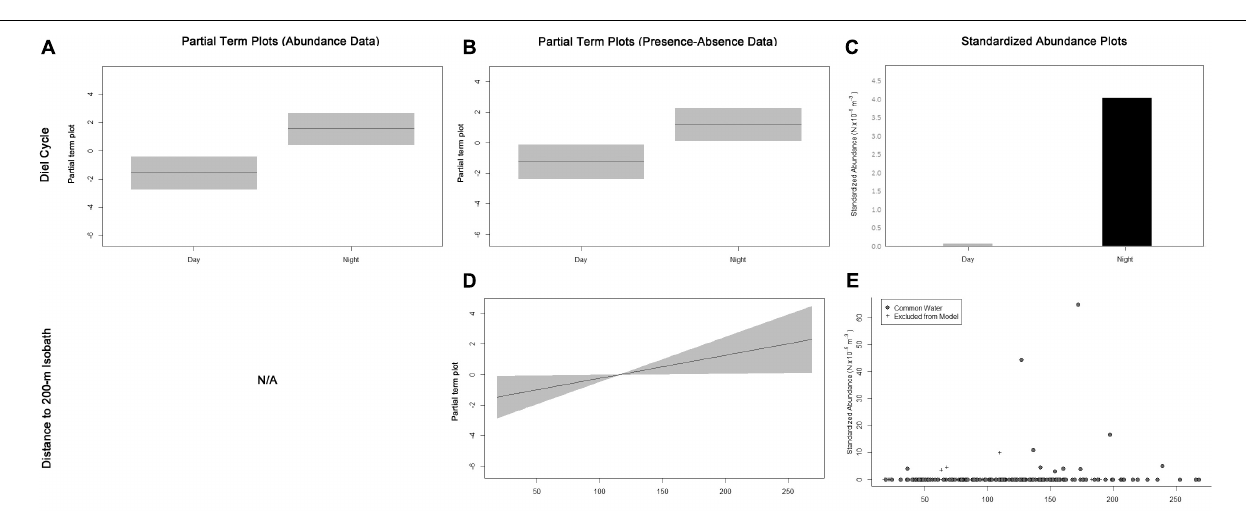
FIGURE 5 | Term plots for the best-fitting models for Auxis thazard data fitted to the abundance data (A) and presence–absence data (B,D) . Standardized abundance plots (C,E) are also presented for all important and marginally important variables. Data that had to be excluded from the model due to missing MOCNESS sensor data are indicated by